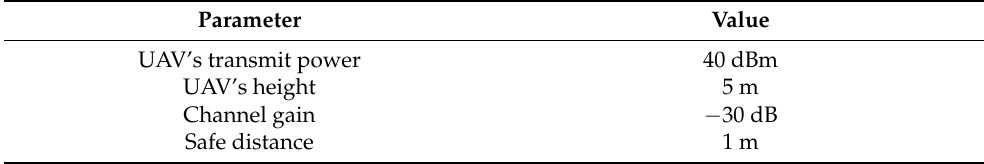
Table 2. Simulation parameters of two-user WPT